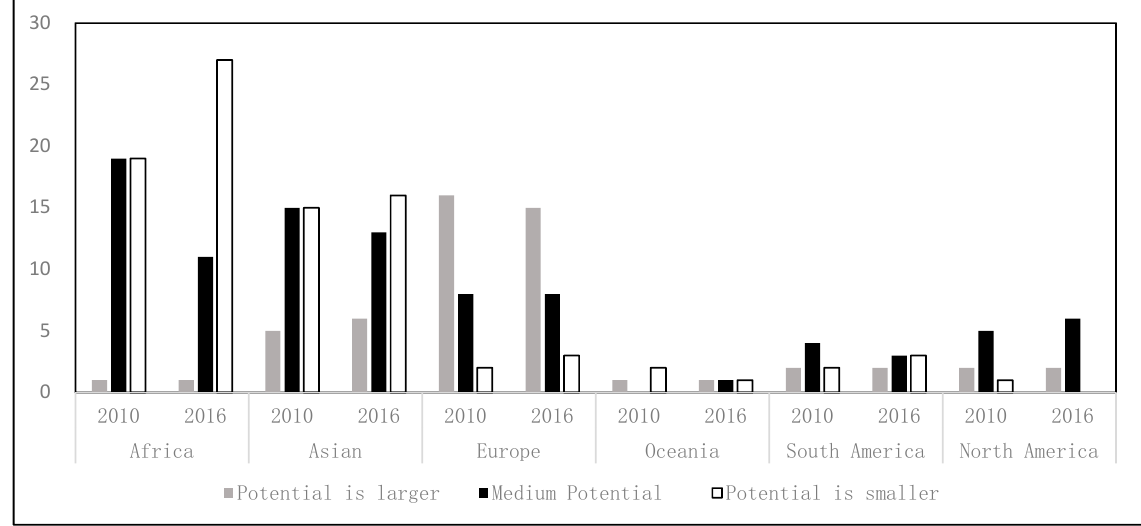
Figure 6. Distribution of political environment within “the belt and road initiative” countries.